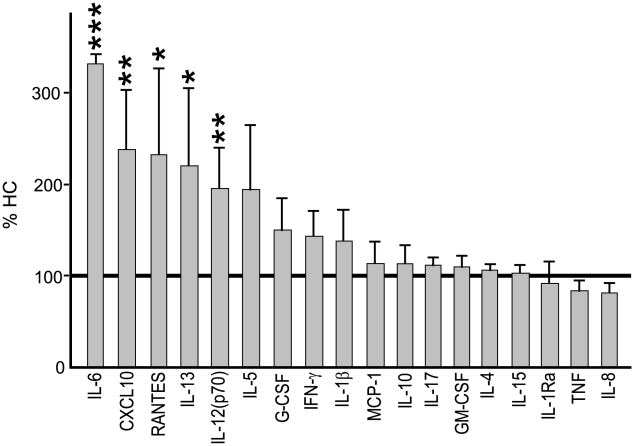
Pro-inflammatory cytokine secretion by UC macrophages (n = 11) in response to HkEc.Results are expressed as a percentage (mean ± SEM) of that secreted by HC cells (absolute values for HC shown in Table S1). (*p<0.05, **p<0.01 and ***p<0.001).